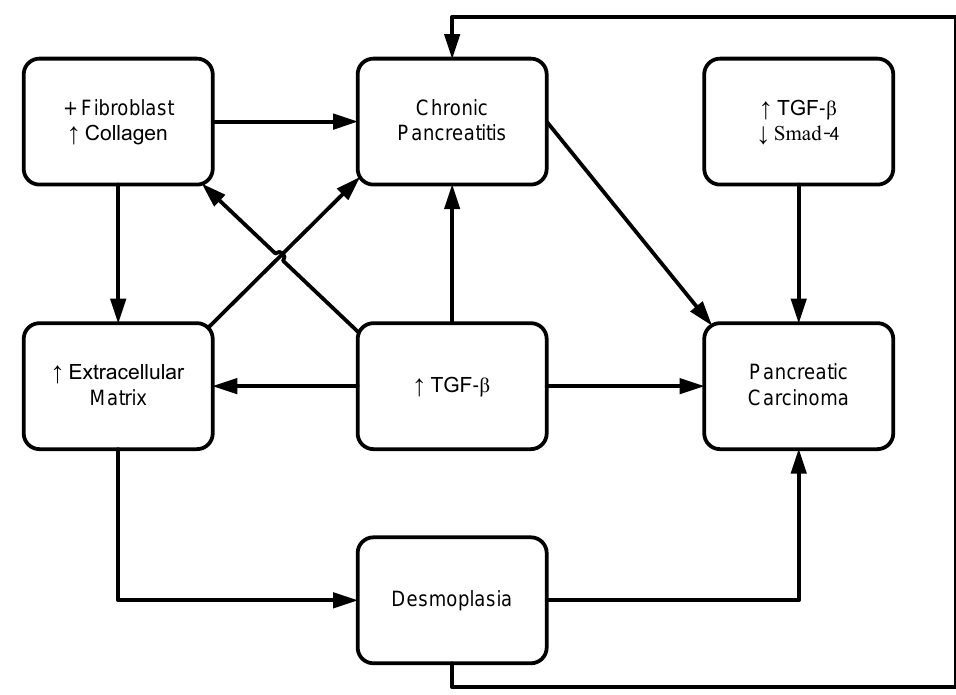
Figure 8. TGF-β-mediated upregulation of desmoplasia in pancreatitis and pancreatic carcinoma